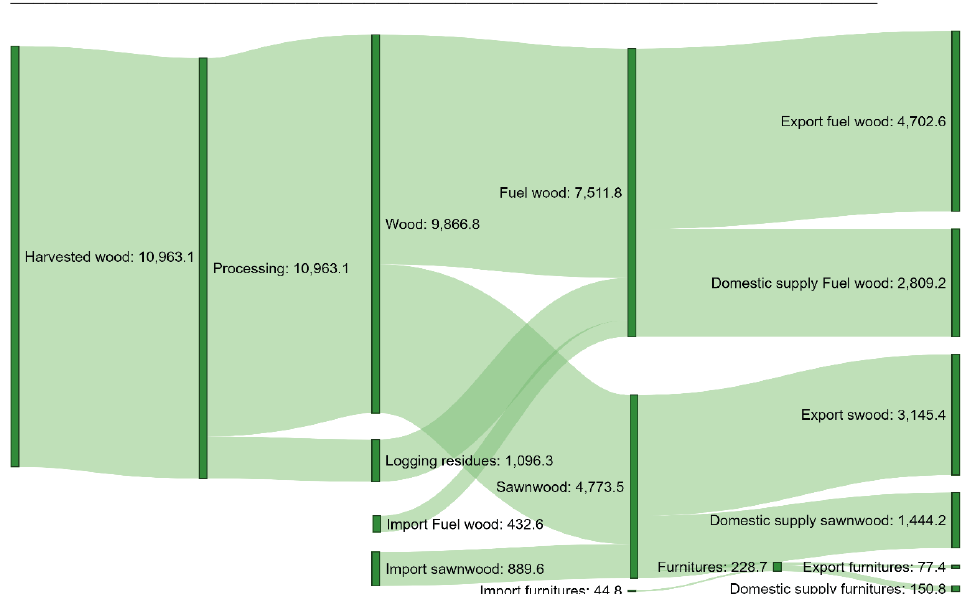
Fig. 6. Sankey diagram for bioresource flows of base scenario in 2030 in the forestry sector, thousand